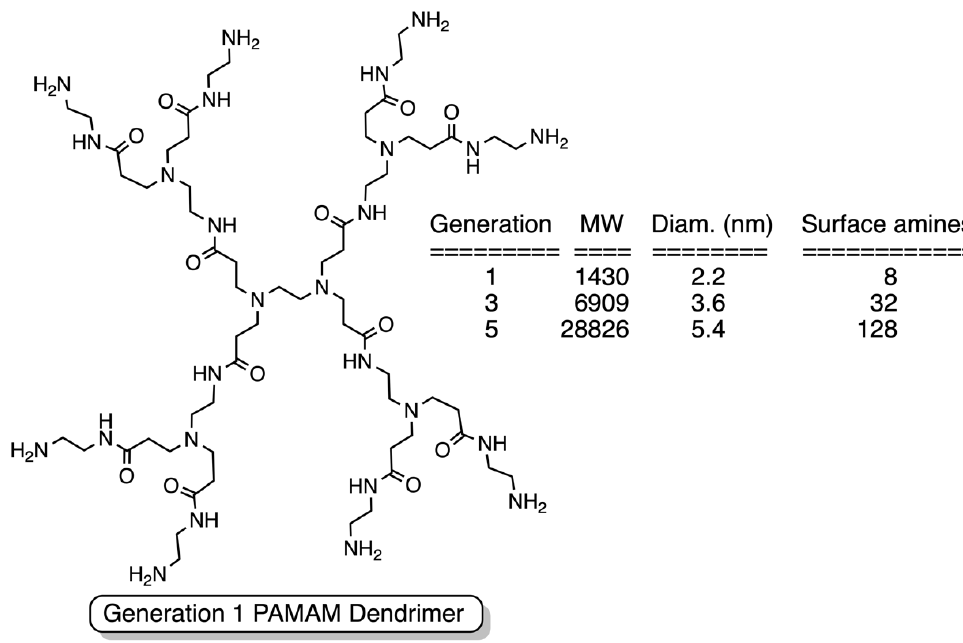
Figure 1. Structures of PAMAM dendrimers.